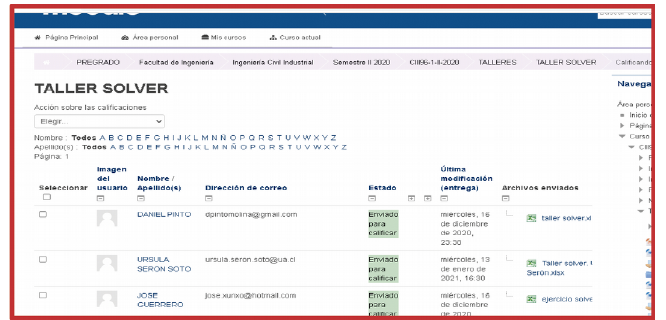
Figure 12. Moodle workshop on Operational Solver research exercise